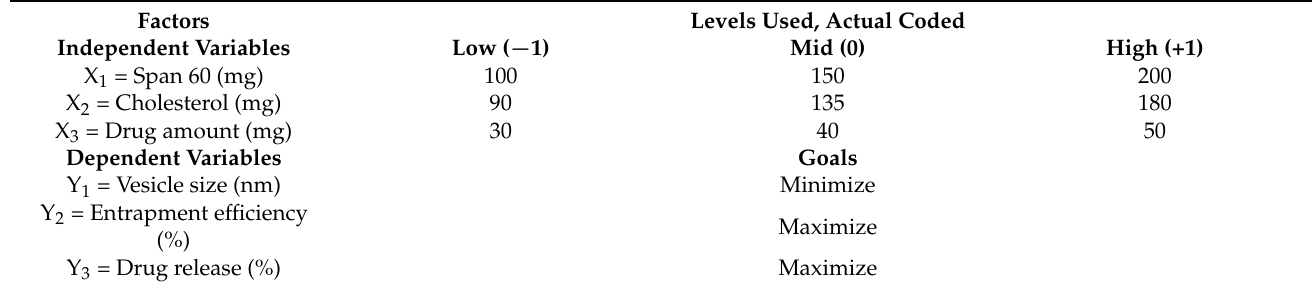
Table 1. Process variables and their levels for experimental design.